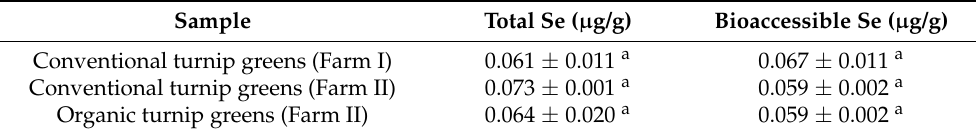
Table 4. Se total and bioaccessible ( µ g/g dry weight) in turnip greens (mean ± standard deviation). Sample